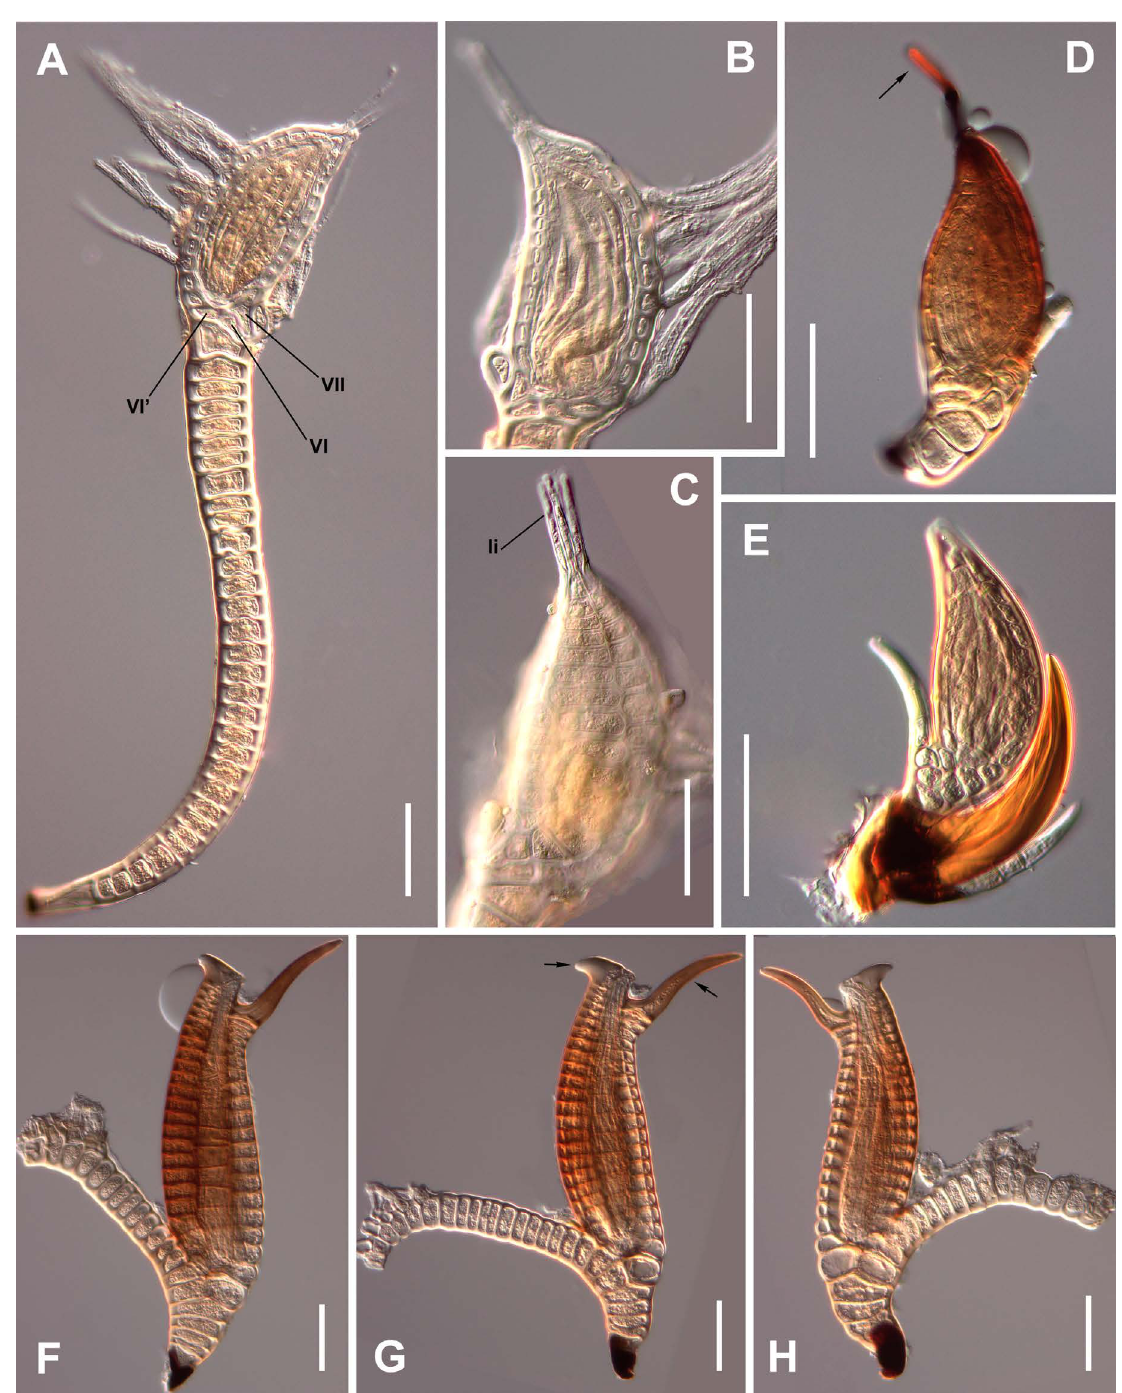
Fig. 2. A – C . Helodiomyces elegans F.Picard. A . Mature thallus with labelling of cells VI, VI’ and VII. B – C . Details of perithecium, including ligules (li) in C. – D . Autoicomyces aquatilis (F.Picard) I.I.Tav.; mature thallus showing the perithecial outgrowth (arrow). – E . Autoicomyces humilis (Thaxt.) Thaxt.; mature thallus at the base of a host claw, and a sporeling on the right. – F – H . Ceratomyces pyrenaeus Santam.; mature thalli showing labelled perithecial excrescences (arrows in G). Scale bars: 50 µm. Photographs from slides ZMUC C-F-122583 (A–C), ZMUC C-F-122567 (D), ZMUC C-F-122566 (E), ZMUC C-F-123551 (F), and ZMUC C-F-123550